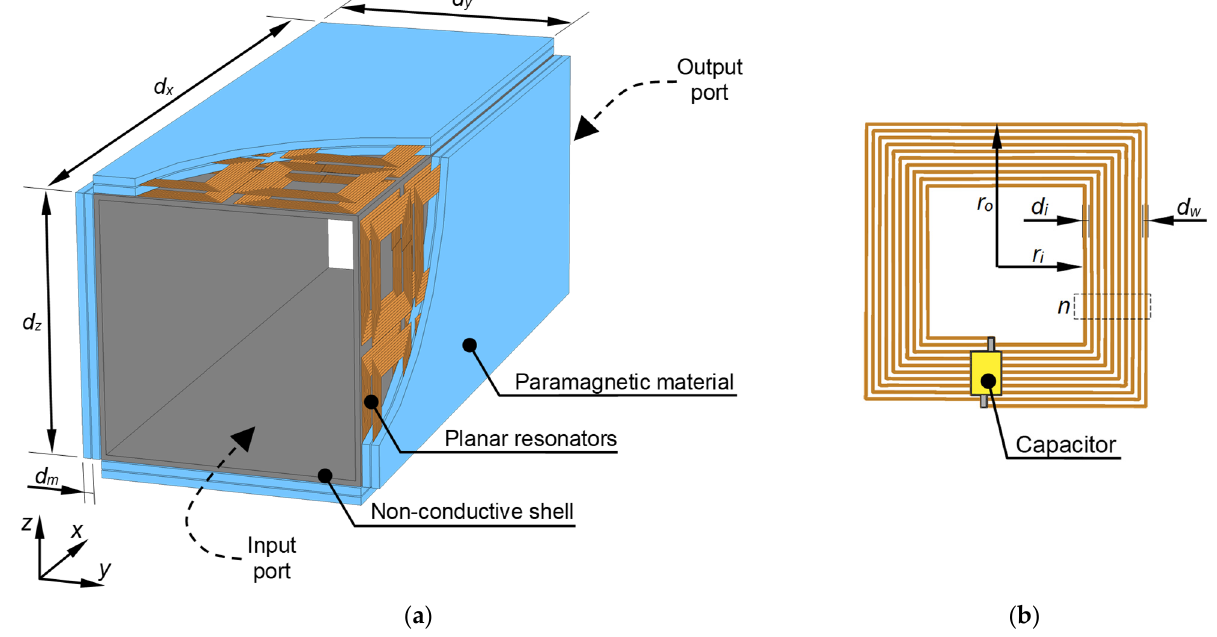
Figure 1. Structure of the medium frequency magnetic meta-hose: ( a ) the source of the magnetic field should have been placed near the input port, while the resulting transfer of the magnetic field is observed at an output port. ( b ) A single resonator.